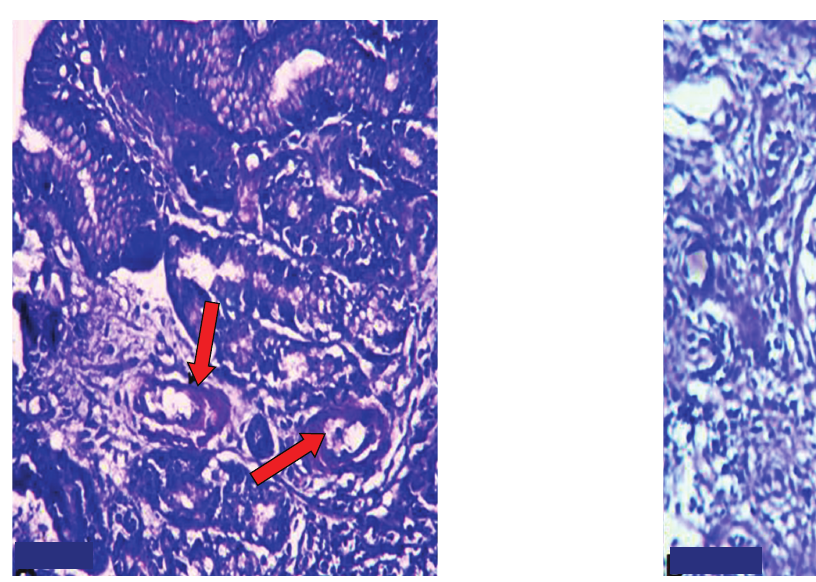
Figure 1: Deposition of amyloid in the walls of blood vessels in lamina propria of duodenum.